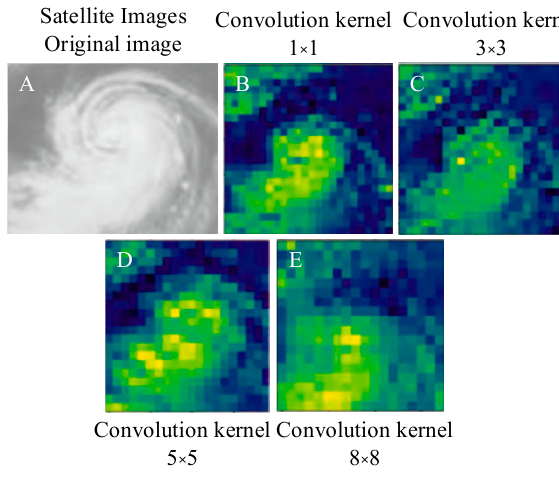
Figure 10. Feature extraction result of some convolution kernels.